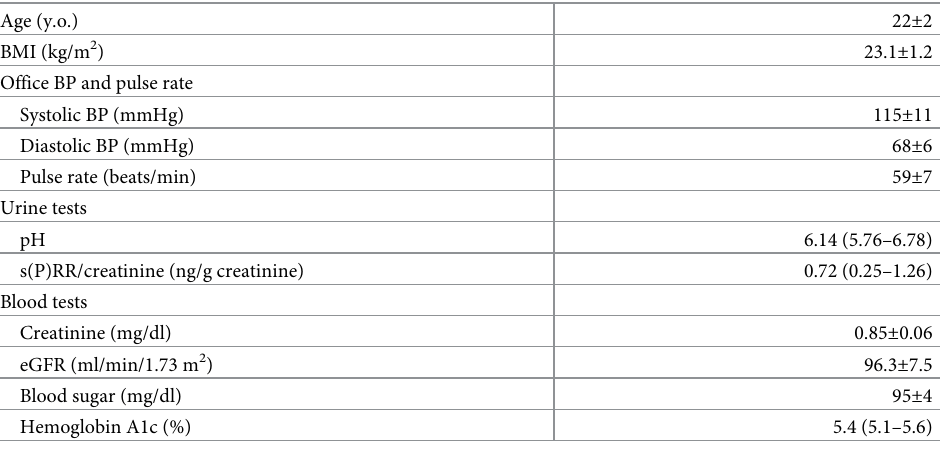
Table 5. Characteristics of the study subjects.